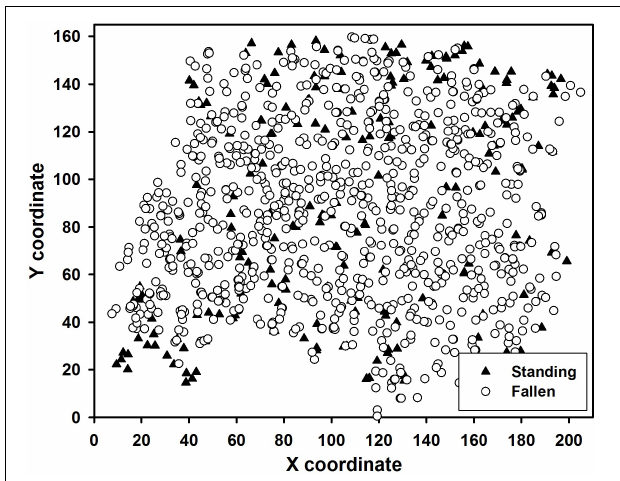
FIGURE 1 | Spatial distribution of 1068 trees within the Taylor study site. Black triangles are standing survivors; white circles are fallen trees.